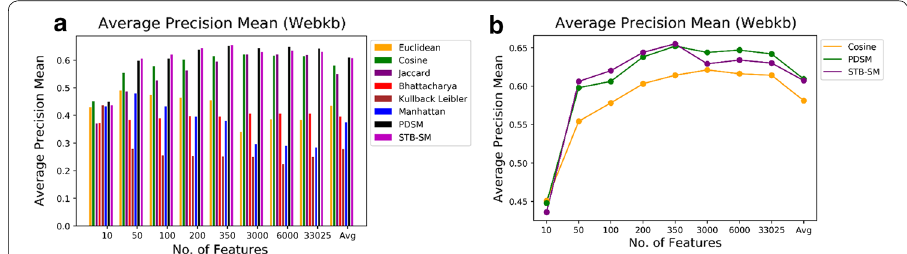
Fig. 6 a AMP over all Measures on all NF values–average results (K competitive measures on all NF values–Average results (K